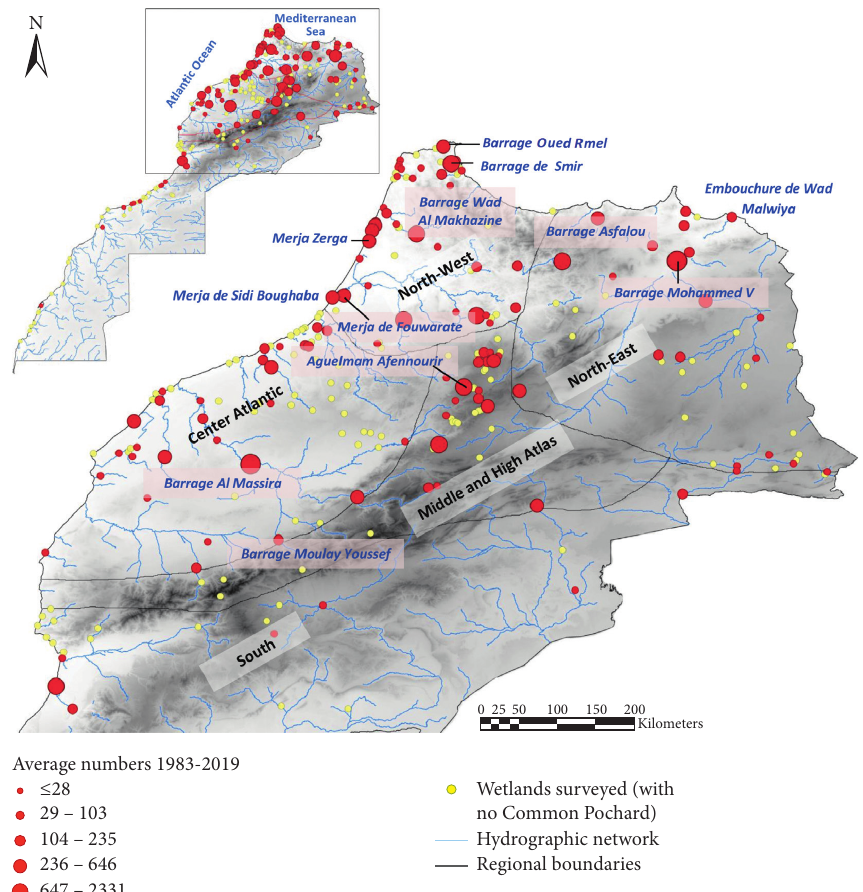
Figure 4: Distribution map of the Common Pochard’s wintering population in Morocco